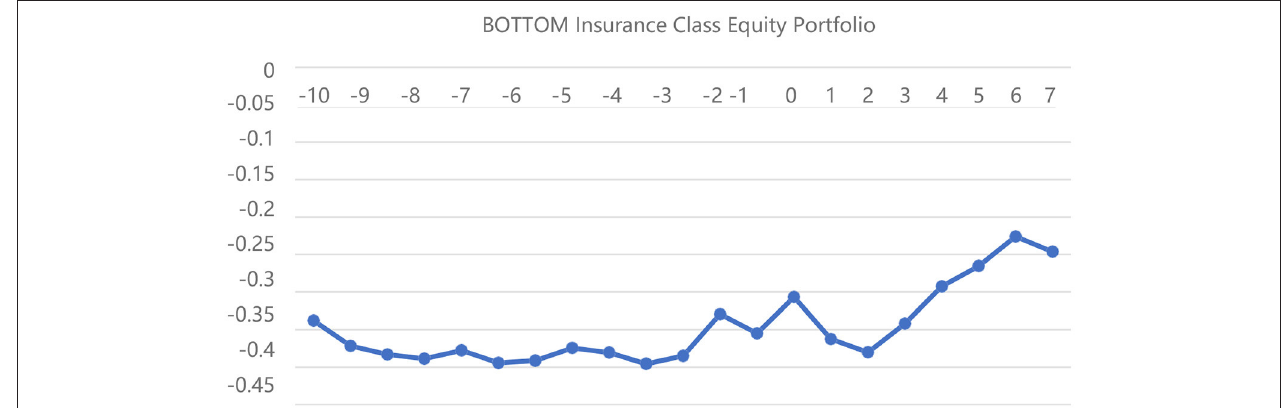
FIGURE 4 | BOTTOM insurance equity portfolio cumulative excess return line chart.